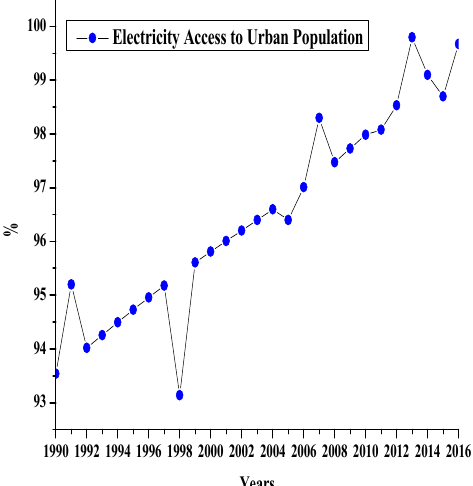
Figure 2. Electricity Access to the Rural Population.